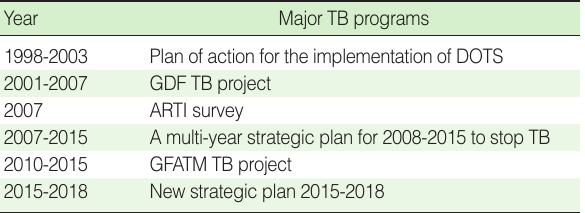
Table 1. Major TB programs of North